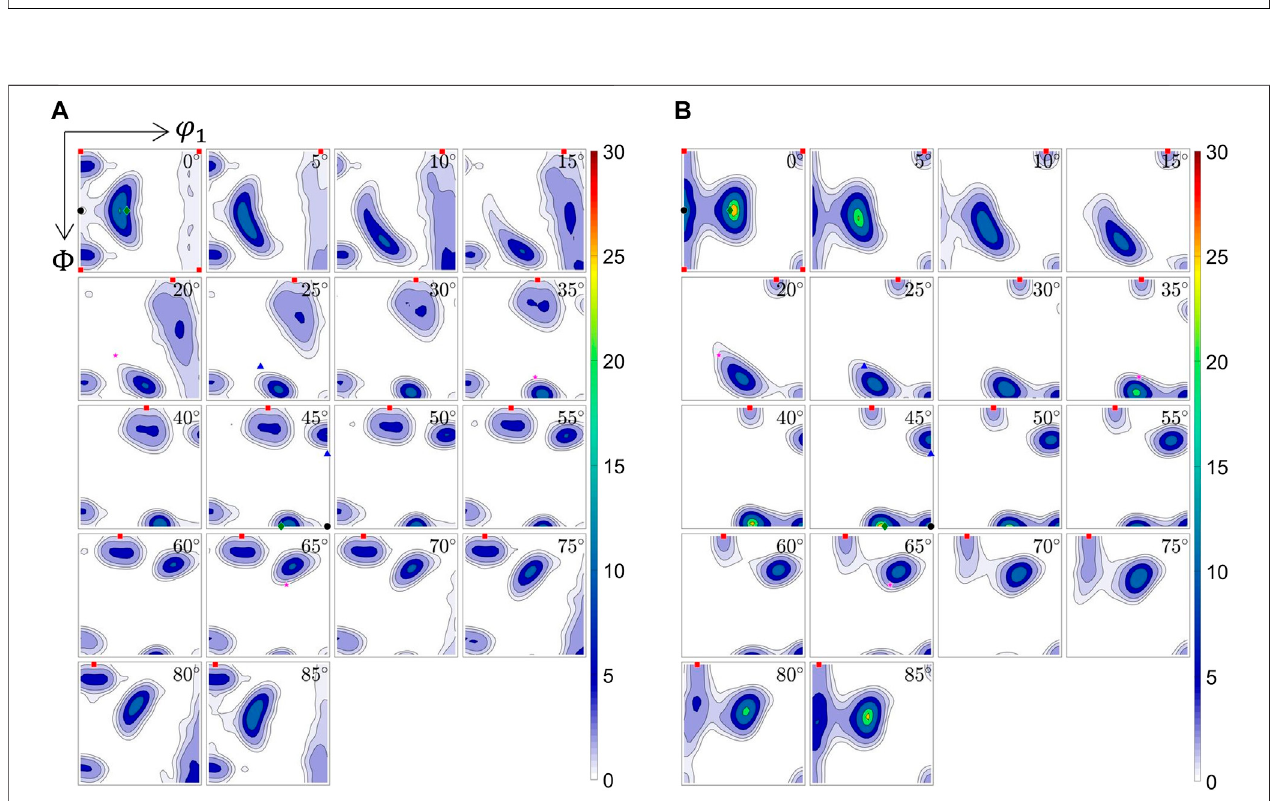
FIGURE 5 | Texture predictions computed by (A) FC-Taylor and (B) Alamel models with parameters giving the best match with the experimentally measured texture for AA6082, T 500 ° C.